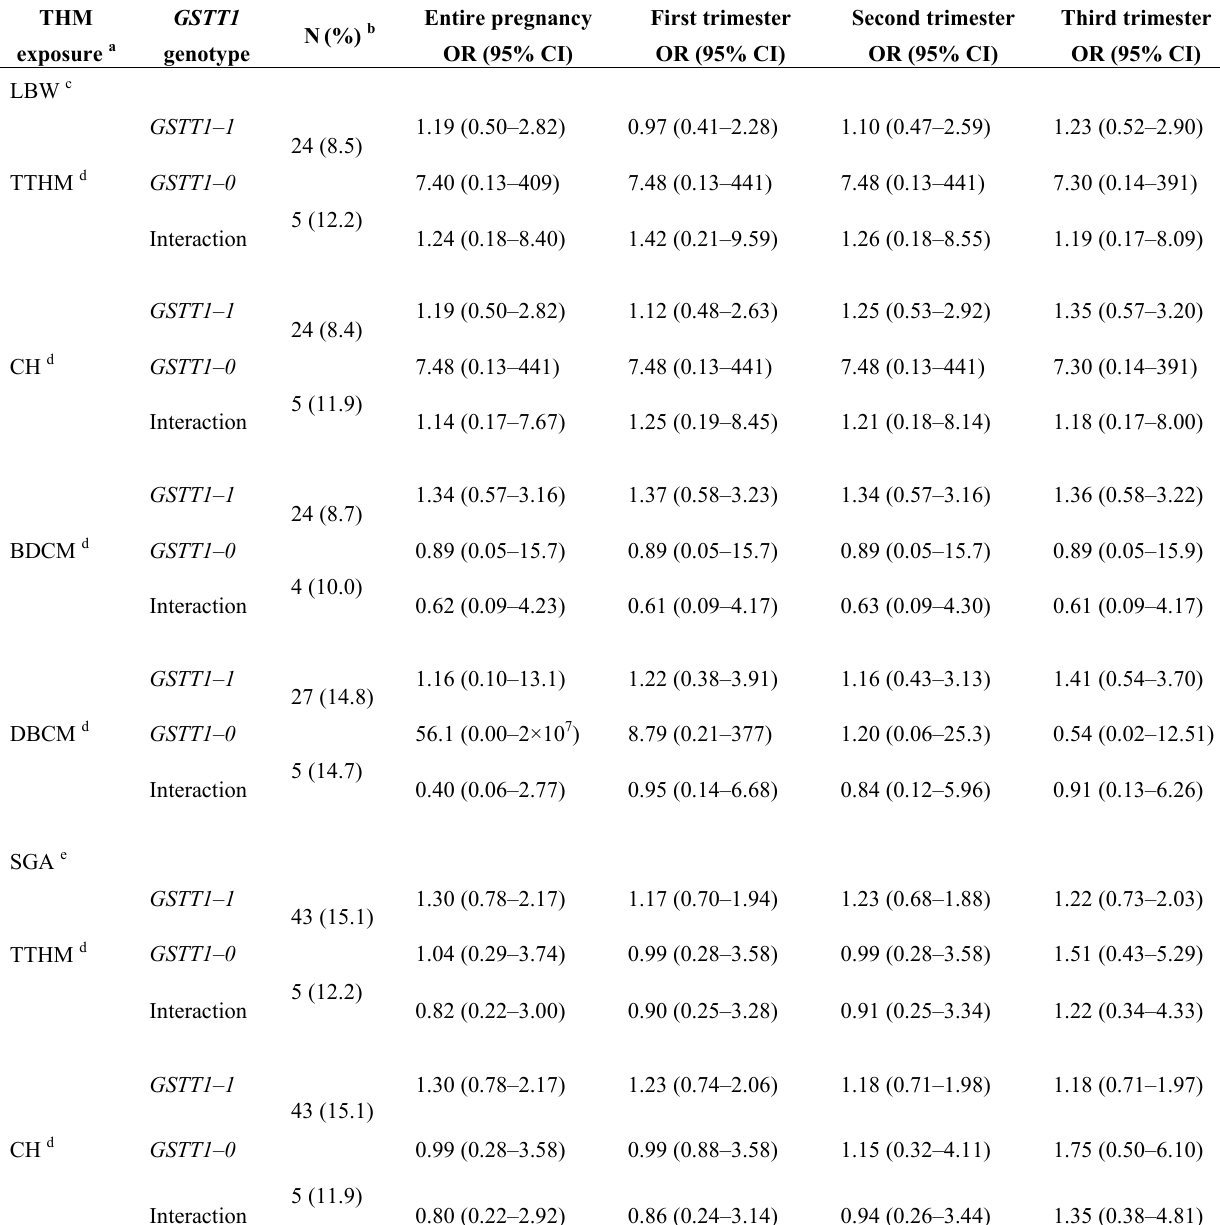
Table 3. Low birth weight and small for gestational age adjusted odds ratios (OR) and 95% confidence intervals (CI) for gestational exposure to internal dose THMs according maternal polymorphisms in the GSTT1